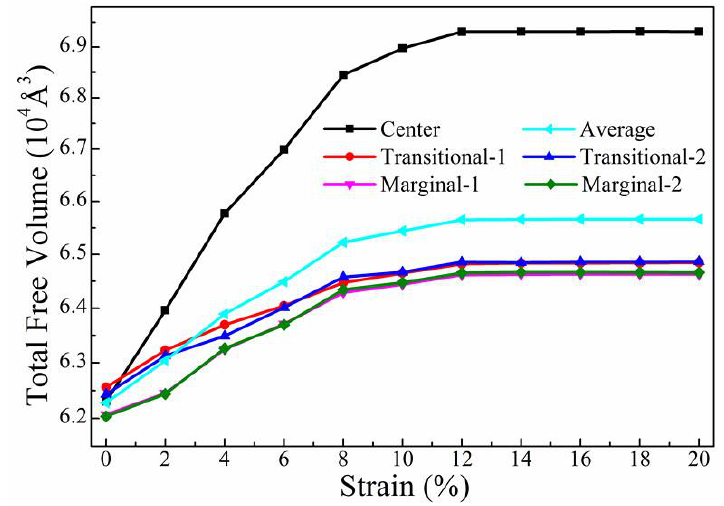
Figure 6. The total free volume in each region of this model under tension, as well as the average value.